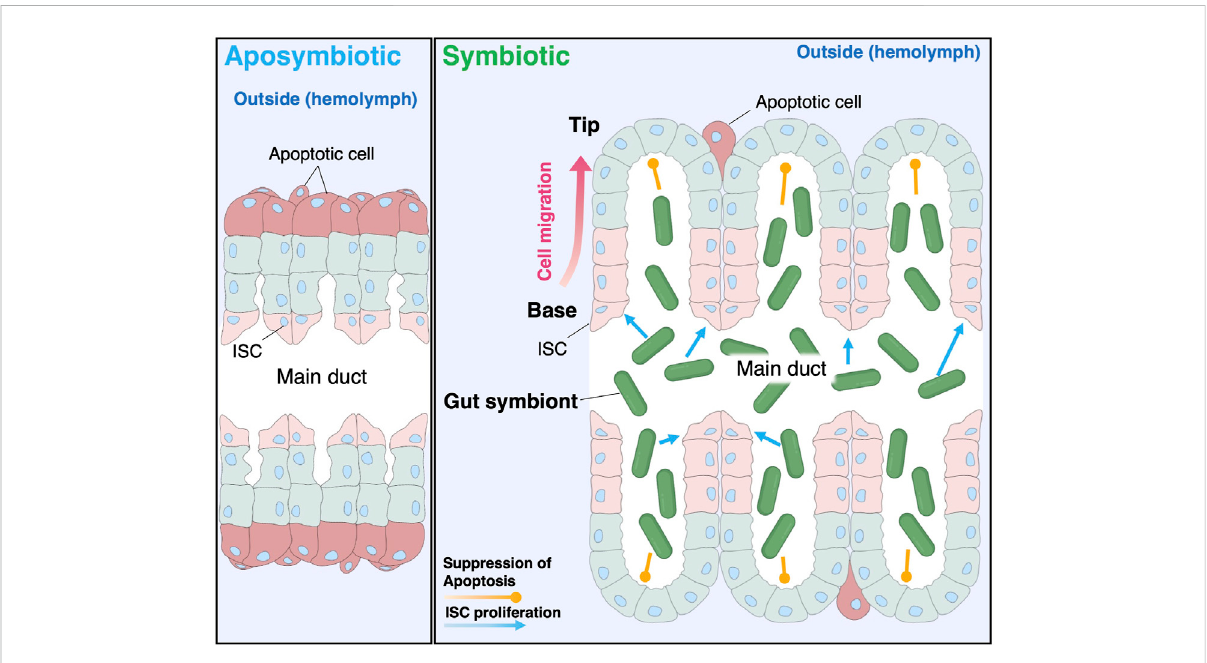
FIGURE 5 Schematic illustration of the symbiont-mediated crypt morphogenesis in the bean bug. C. insecticola stimulates the proliferation of ISCs localizedatthecryptbaseandsimultaneouslyinhibitsapoptosisatthecrypttip,resultinginthedramaticalterationofthecryptmorphogenesisinthe bean bug R. pedestris